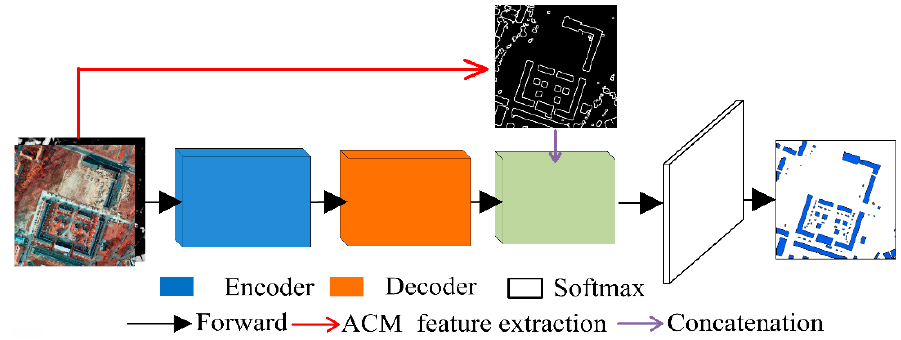
Figure 3. The architecture of the CNN_ACM_1 building boundary extraction method.